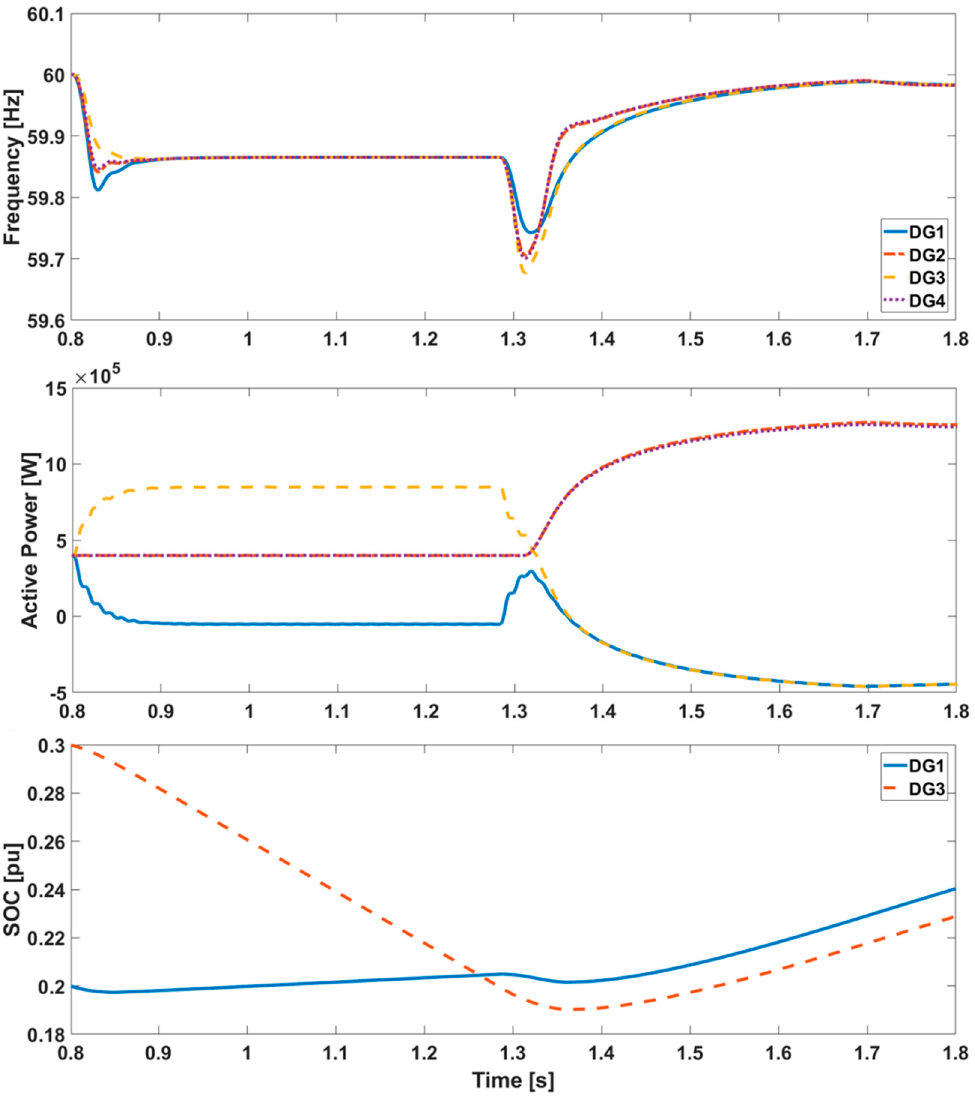
Figure 10. SOC restoration results for SOC difference of 10% between DG1 and DG3.